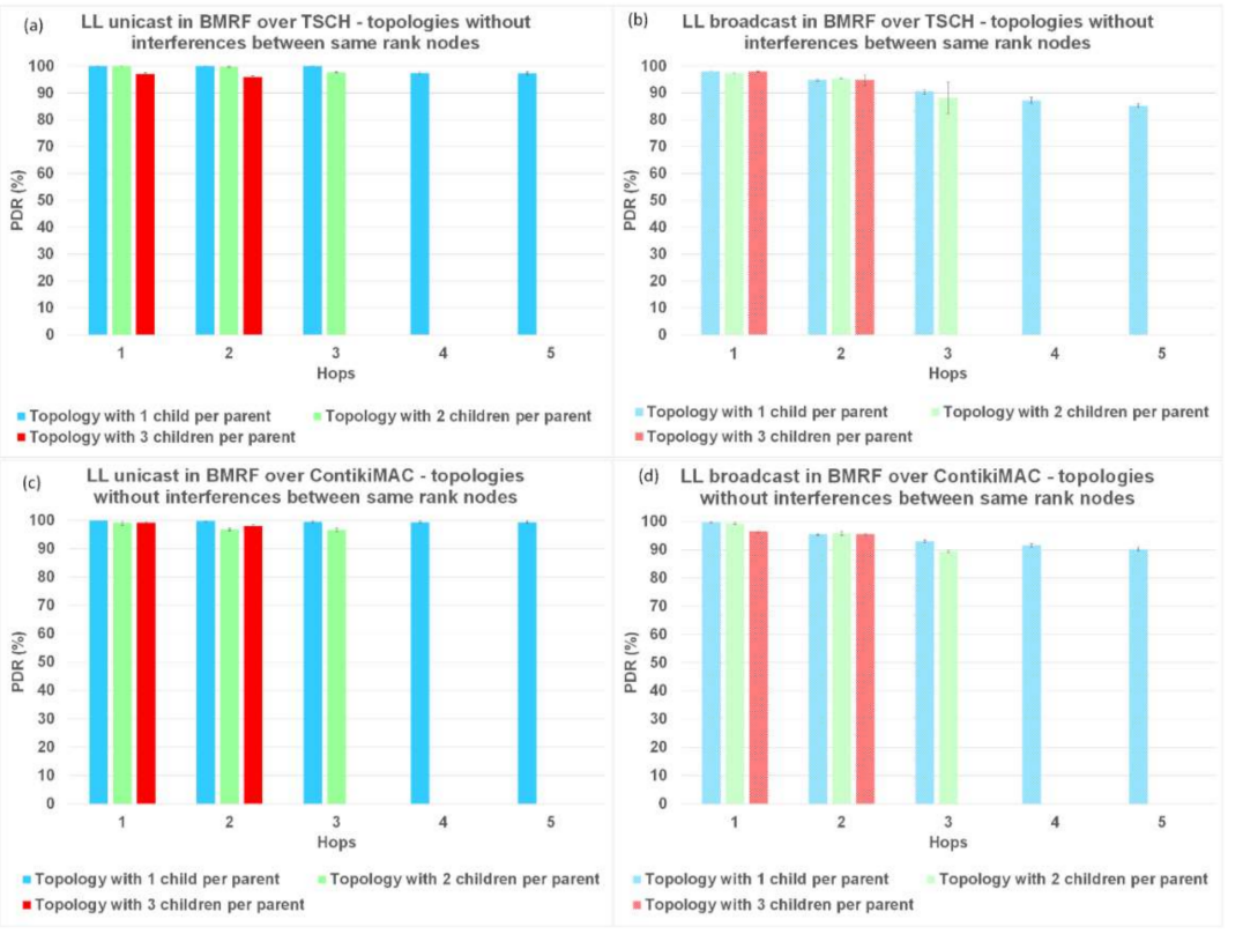
Figure 8. Packet delivery ratio (PDR) comparison between LL unicast and LL broadcast and between ContikiMAC and TSCH on topologies without interference between same rank nodes. ( a ) Results for LL unicast in BMRF over TSCH. ( b ) Results for LL broadcast in BMRF over TSCH. ( c ) Results for LL unicast in BMRF over ContikiMAC. ( d ) Results for LL broadcast in BMRF over